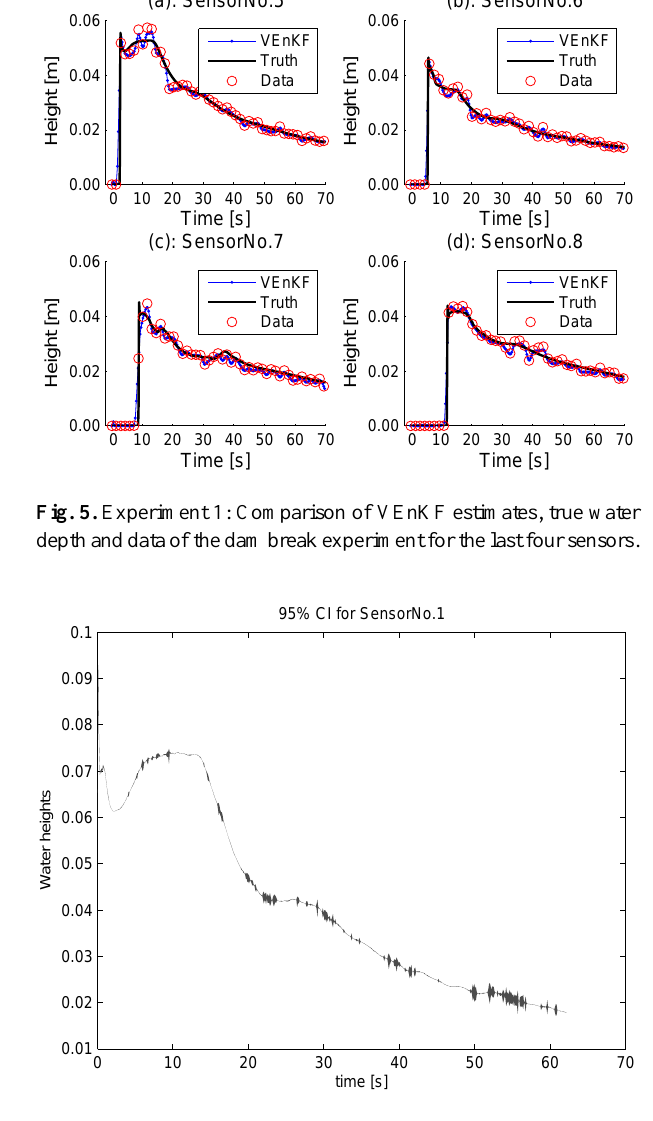
Fig. 6. 95% confidence region is shown for the location of Sensor No.